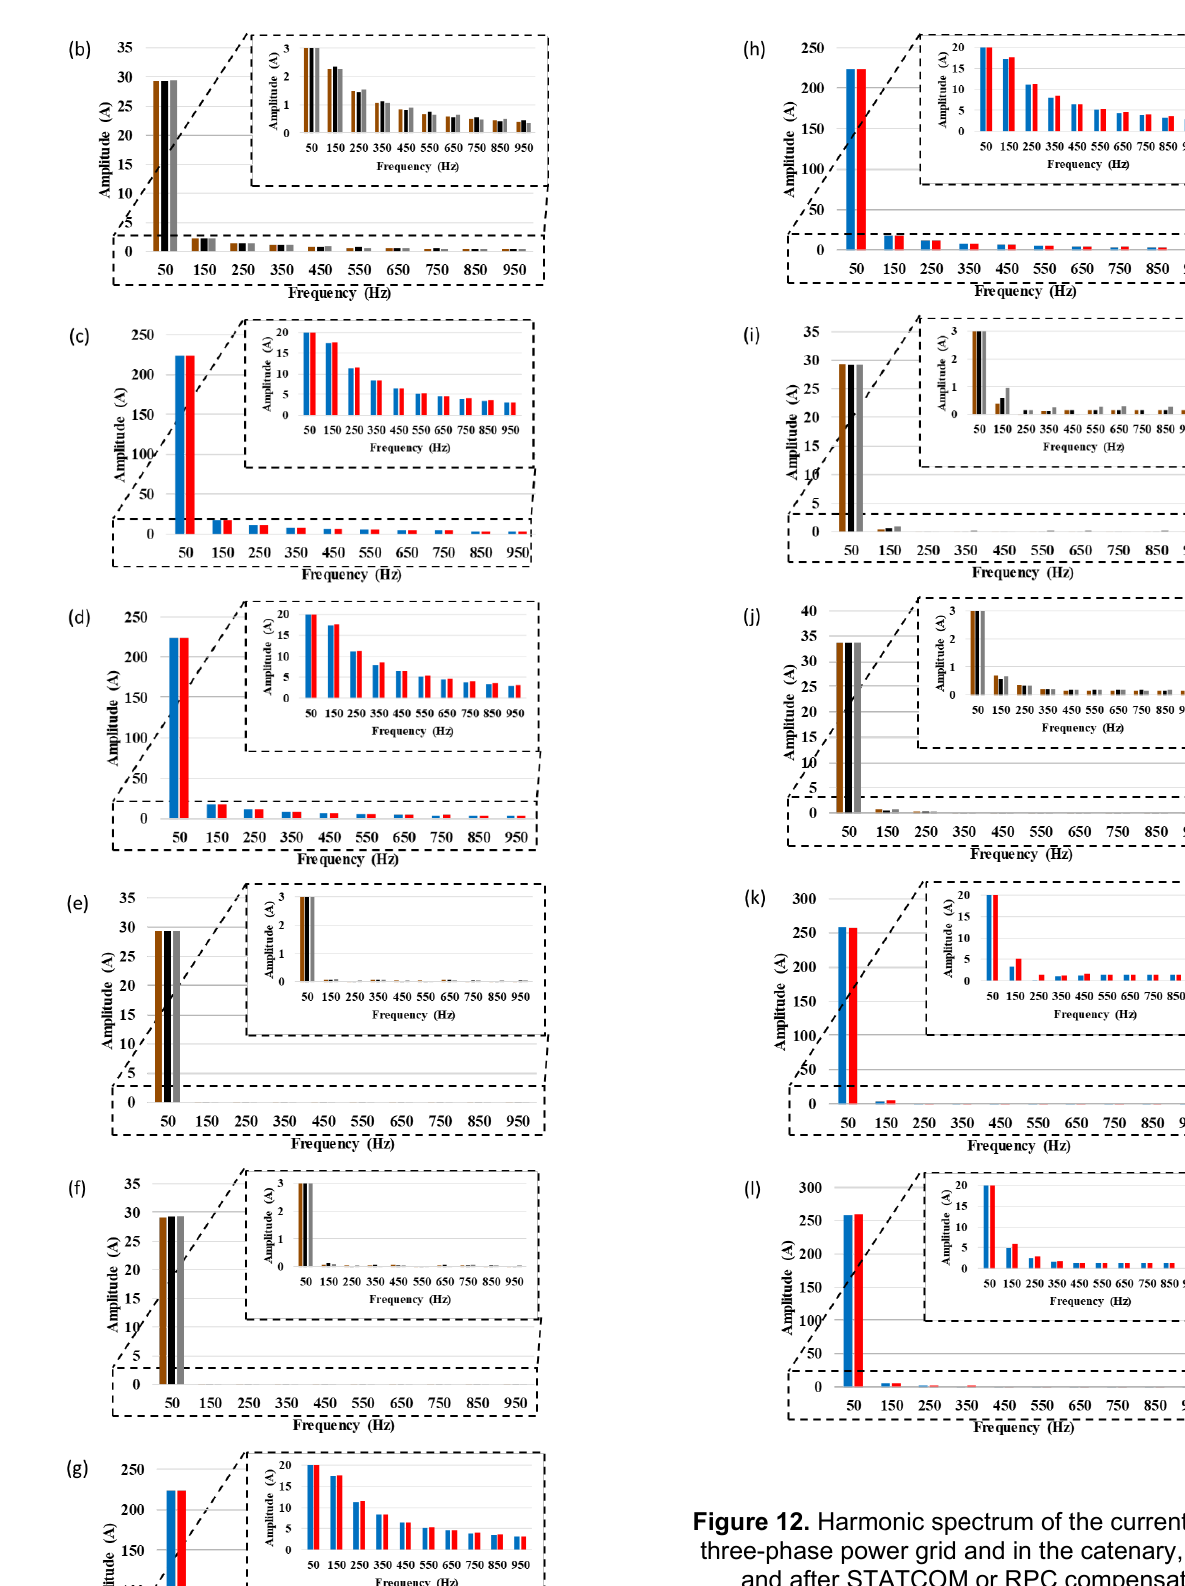
Regarding the compensation currents during the interval when one locomotive is found in each catenary, it is possible to verify that when a V/V power transformer